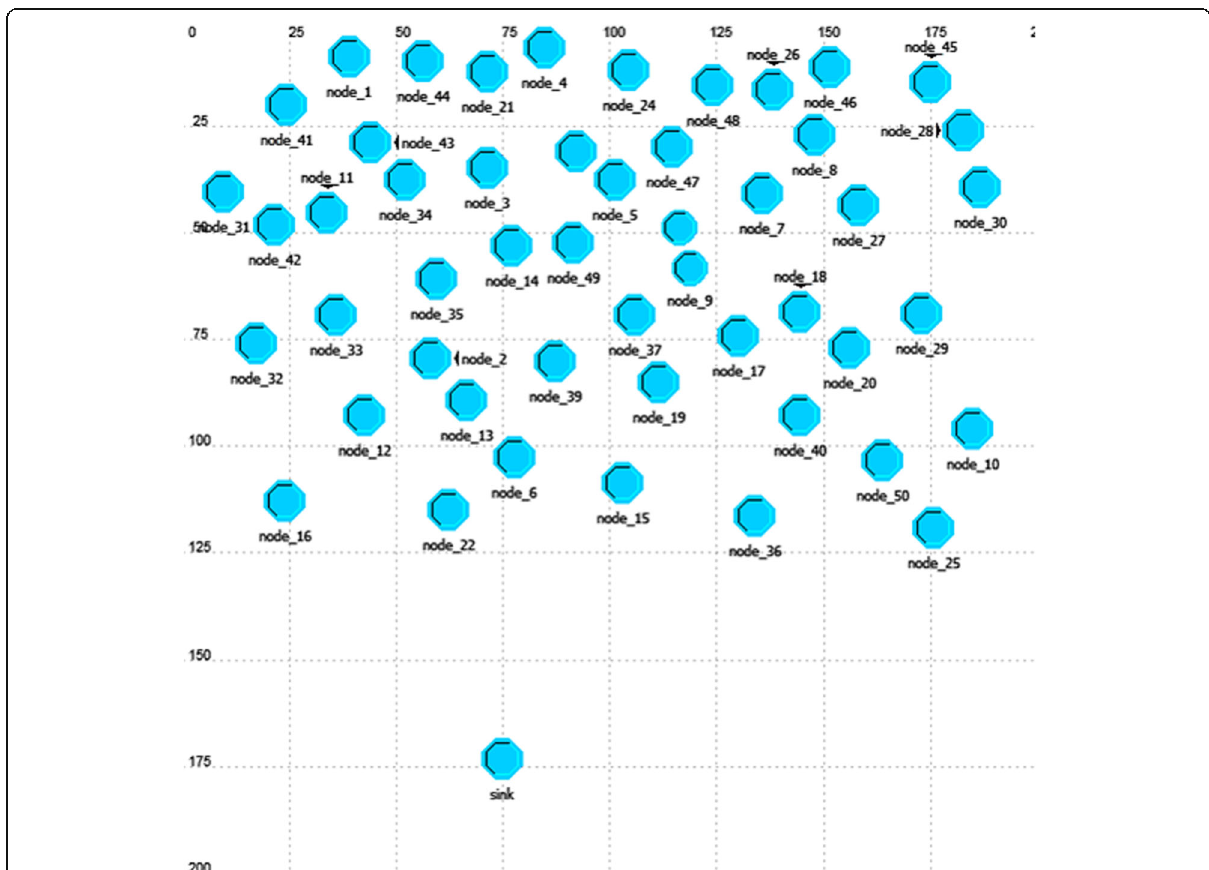
Fig. 6 The 50-node network model of the WSN. The 50-node network model of WSN is shown in this figure. Fifty nodes are randomly distributed between the area of ( x = 0, y = 0) and ( x = 200, y = 125) with the sink node at ( x = 75, y =